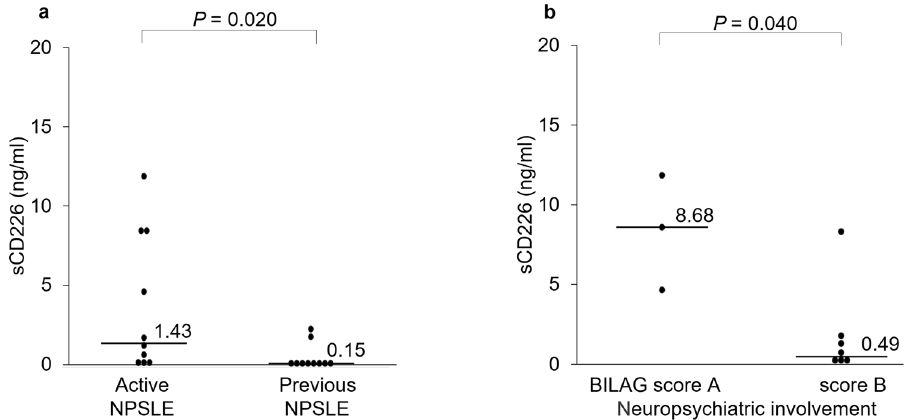
Figure 4. Serum sCD226 levels in SLE patients with neuropsychiatric manifestation. ( a ) Serum sCD226 levels were compared between active NPSLE patients and previous NPSLE patients. ( b ) Serum sCD226 levels were compared between neuropsychiatric SLE patients with BILAG category A and those with BILAG category B. Each data point represents a single subject. Horizontal lines show the median. Statistical differences among groups were evaluated using the Mann–Whitney U test. sCD226 soluble CD226, SLE Systemic lupus erythematosus, NPSLE neuropsychiatric systemic lupus erythematosus, BILAG British Isles Lupus Assessment